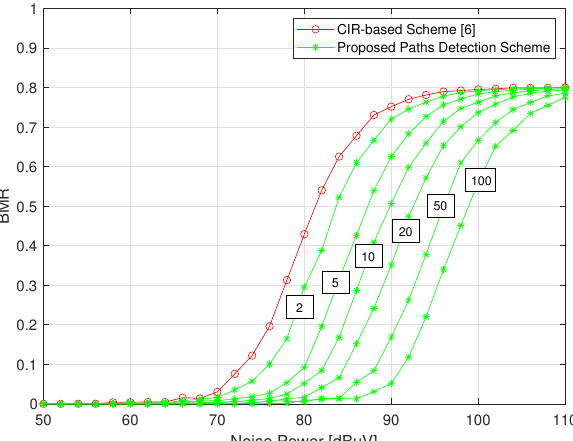
Figure 15. BMR variations for the proposed scheme and the PT scheme, with different number of observations: 2, 5, 10, 20, 50, and